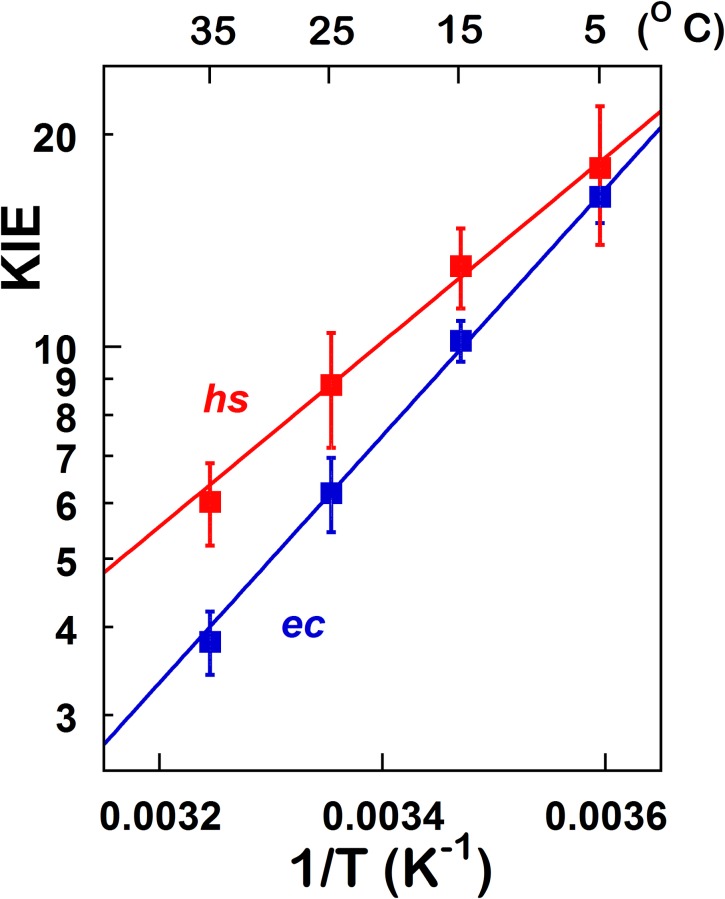
Arrhenius plot of KIEints on the proton abstraction. [ecTSase data from [22]].